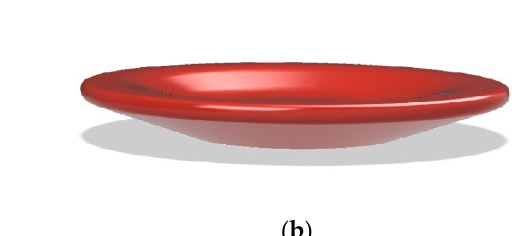
Figure 2. Limitation examples: ( a ) bridging; ( b ) overhangs.